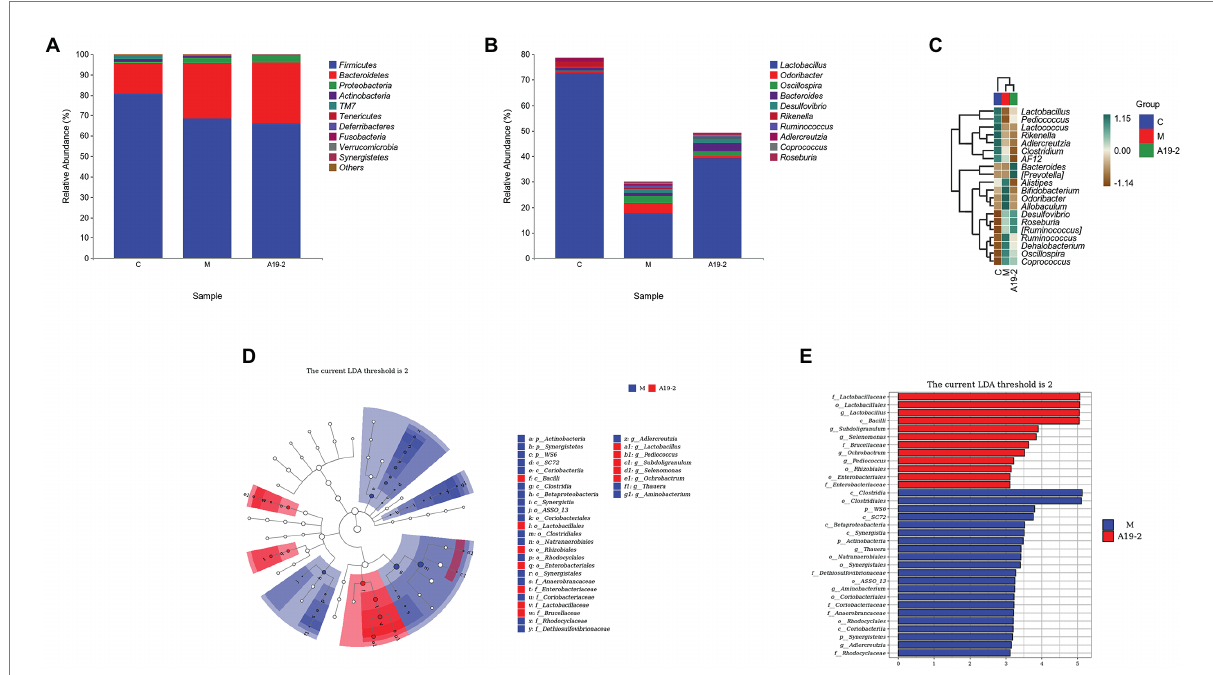
FIGURE 8 Dynamic changes of intestinal microbial taxonomic composition. (A) Analysis of intestinal microbial abundance at phylum level; (B) analysis of intestinal microbial abundance at genus level; (C) heat map of intestinal microbiota at genus level; (D) LEfSe taxonomic cladogram. Colored nodes from the outer ring to the inner ring represent the relationship between the intestinal flora from the genus level to the phylum level; and (E) groups with LDA scores